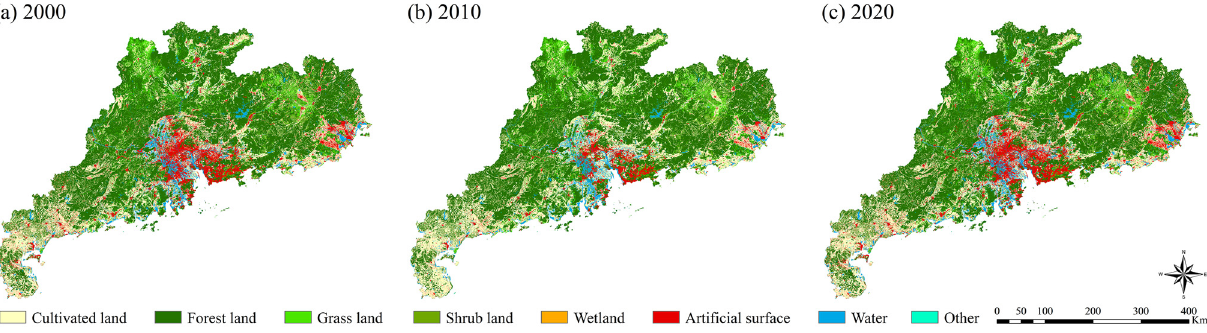
Figure 5. Historic LUCC data for 2000, 2010, and 2020.